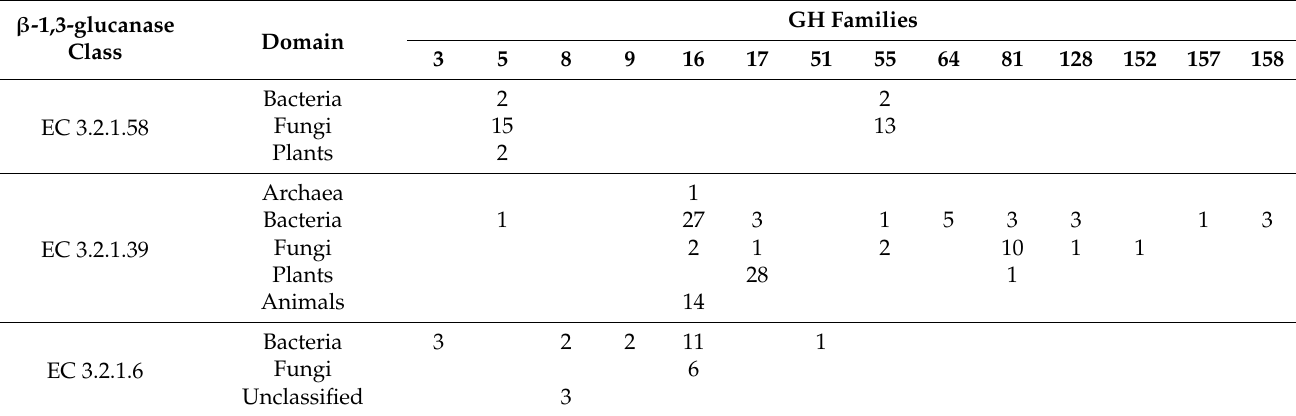
Table 1. Distribution of characterized β -1,3-glucanases across glycoside hydrolase (GH) families and taxa, according to the CAZy.org database (as of February